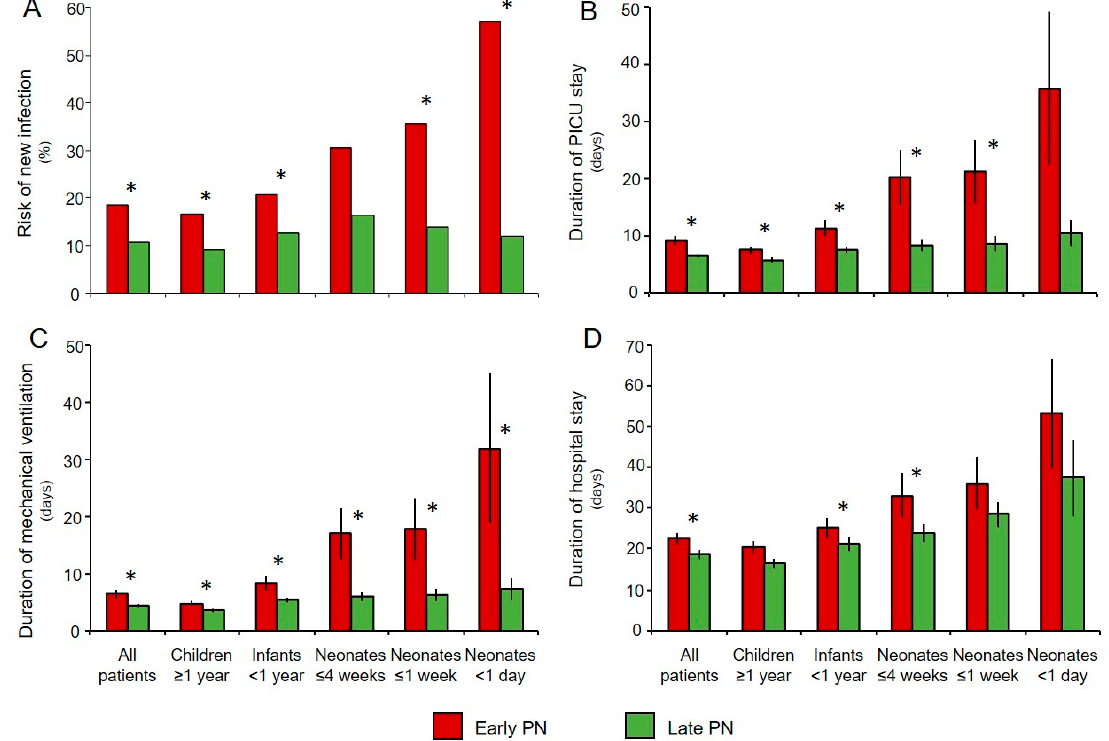
Figure 1. Bars represent incidence of ( A ) the risk of acquiring a new infection in PICUs (percentage), ( B ) duration (days) of PICU stay, ( C ) duration (days) of mechanical ventilation, and ( D ) duration (days) of total hospital stay. Whiskers indicate standard errors of the mean. Asterisks represent p values < 0.05 obtained with multivariable analysis adjusting for baseline risk factors (treatment center, age, risk of malnutrition (STRONGkids score), diagnosis upon admission and severity of illness (Pediatric Logistic Organ Dysfunction (PeLOD) score, and Pediatric Risk of Mortality 2 (PIM2) score) for all patients; treatment center, risk of malnutrition, diagnosis upon admission and severity of illness for children and infants; and treatment center, type of illness upon admission (medical, surgical cardiac, surgical other), severity of illness and weight for age z score for neonates).